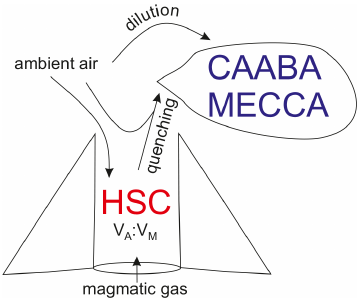
Figure 2. Sketch of the initialization process of the